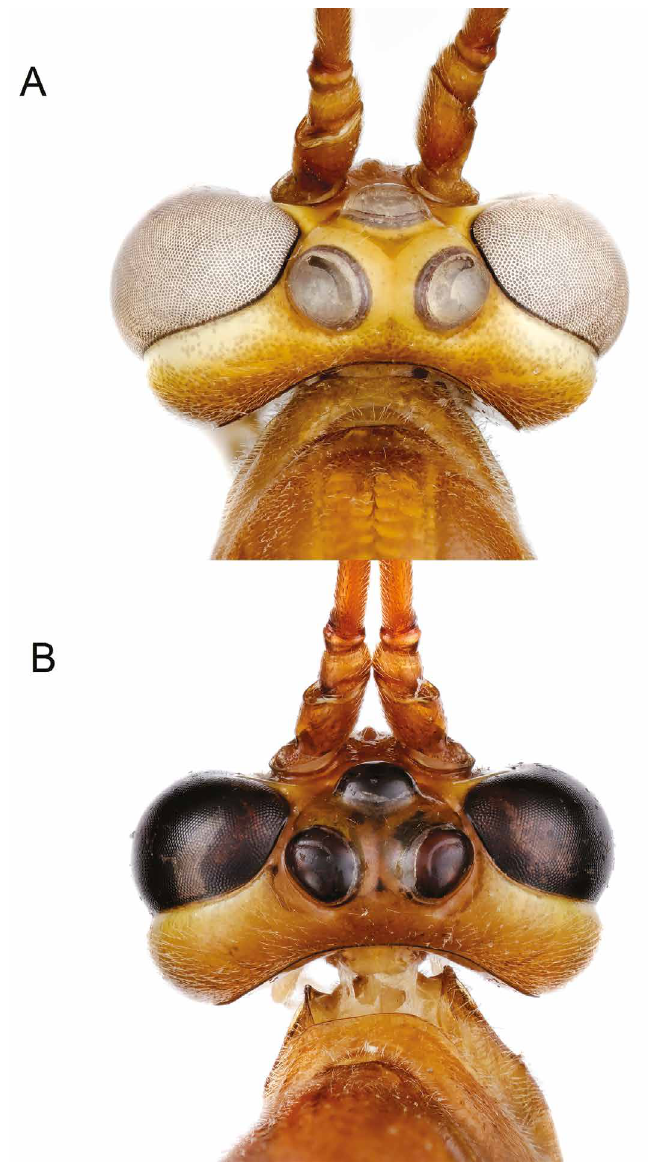
Fig. 5. Head, dorsal view. A . Enicospilus cerebrator Aubert, 1966, ♀. B . E. cederbergi sp. nov., paratype,